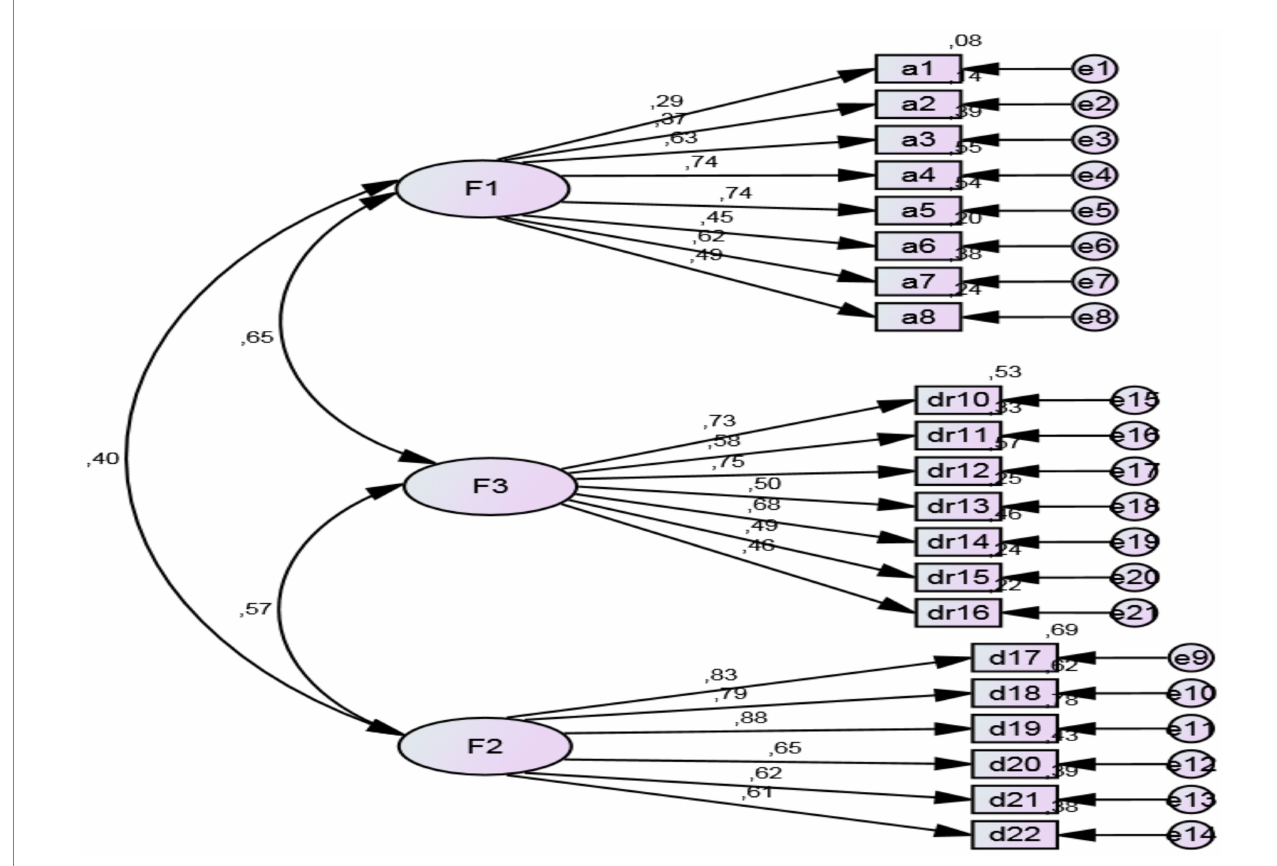
FIGURE 1 The structural equations of the